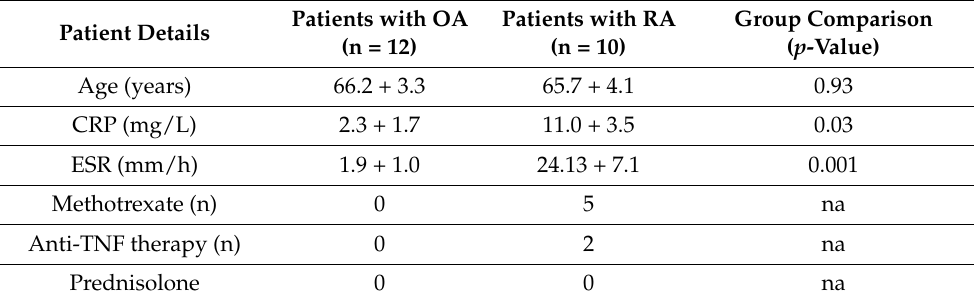
Figure 1A). Among patients with RA, muscle 11β-HSD1 activity correlated with circulat- ing CRP levels (R 2 = 0.131, p = 0.05; Figure 1B). Real-time PCR showed higher expression of the inflammatory cytokine IL6 in muscle samples from patients with RA compared to patients with OA (fold change = 8.65, p < 0.05; Figure 1C). Expression of this tissue-specific marker of inflammation correlated with expression of 11β-HSD1 among patients with RA (R 2 = 0.369, p < 0.05; Figure 1D). Similarly, expression of the inducible inflammatory acti- vator COX2 correlated with 11β-HSD1 expression in muscle biopsies from patients with RA (R 2 = 0.672, p < 0.05; Figure 1E). Finally, muscle samples from patients with RA com- pared to OA exhibited higher expression of Forkhead box protein O1 ( FOXO1) and myo- statin ( MSTN ), negative regulators of muscle growth (fold changes 2.35, p < 0.05 and 3.62, p < 0.05 respectively; Figure 1F,G). Taken together, these data demonstrate that 11β-HSD1 activity is elevated in the skeletal muscle of patients with RA relative to patients with OA, and that 11β-HSD1 upregulation correlates with systemic and tissue-specific markers of inflammation. Table 1. Patients’ characteristics for human skeletal muscle biopsies. Table 1. Patients’ characteristics for human skeletal muscle biopsies.